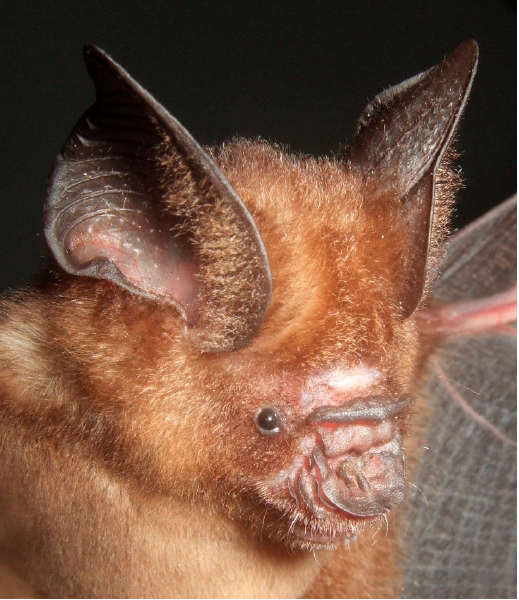
Figure 14. Hipposideros larvatus , adult male. Photograph by Vu Dinh Thong.